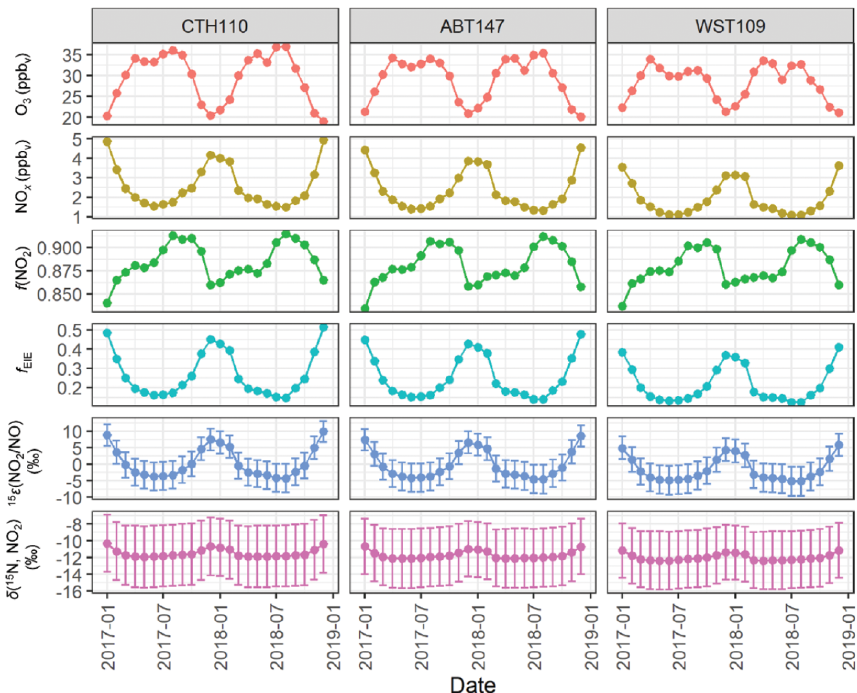
Figure 7. GEOS-Chem output of O 3 , NO x , and f (NO 2 ) data and the calculated fraction of NO x at isotope equilibrium ( f EIE ), the NO 2 / NO enrichment factor 15 ε (NO 2 / NO), and δ ( 15 N, NO 2 ) at the considered CASTNET sites. The error bars in 15 ε (NO 2 / NO) and δ ( 15 N, NO 2 ) correspond to the propagated